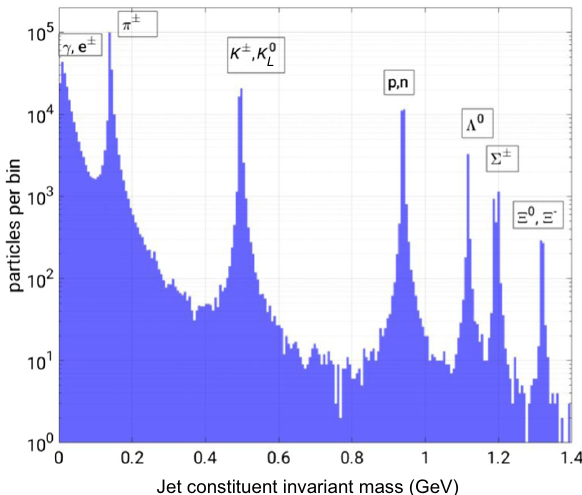
FIG. 32. Jet invariant mass spectrum from the HEPSIM simulations for 100-TeV collisions.